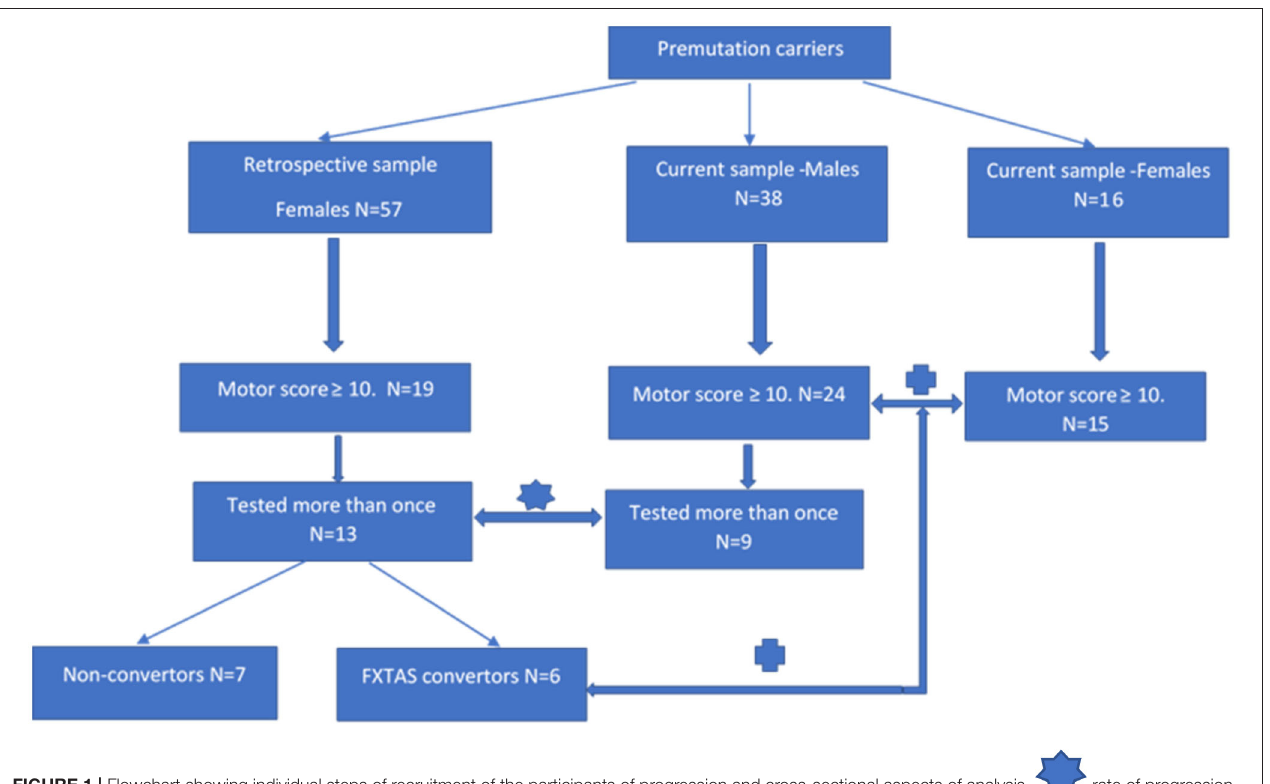
FIGURE 1 | Flowchart showing individual steps of recruitment of the participants of progression and cross-sectional aspects of analysis. rate of progression study; male-female comparison